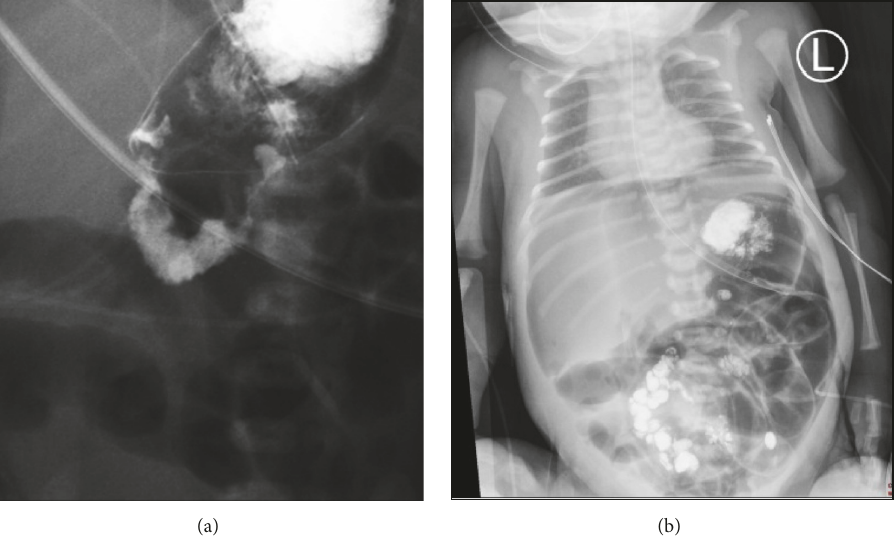
Figure 3: Radiographic images from day 1 and day 2 postnatally. (a) Contrast study performed on day 1 of life excluding malrotation and (b) large pneumoperitoneum evident on abdominal X-ray on day 2 of